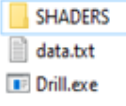
Figure 16. Source project folder.